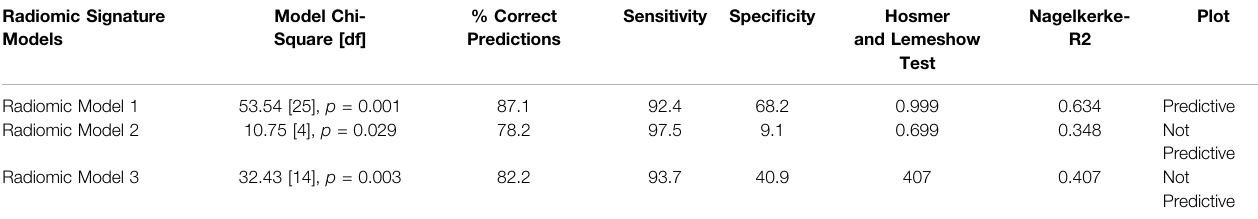
TABLE 1 | Multivariate Logistic Regression Analysis of Muscle Radiomic Phenotype Predictive Models (events = 29, n = 101).